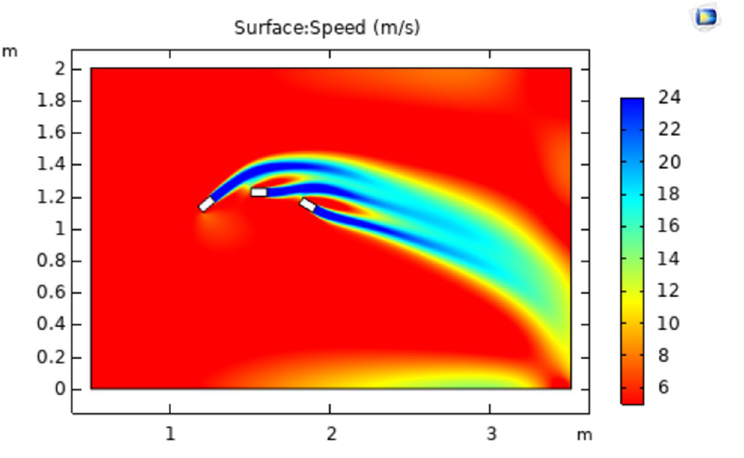
Fig 6. Flow velocity distribution from nozzles